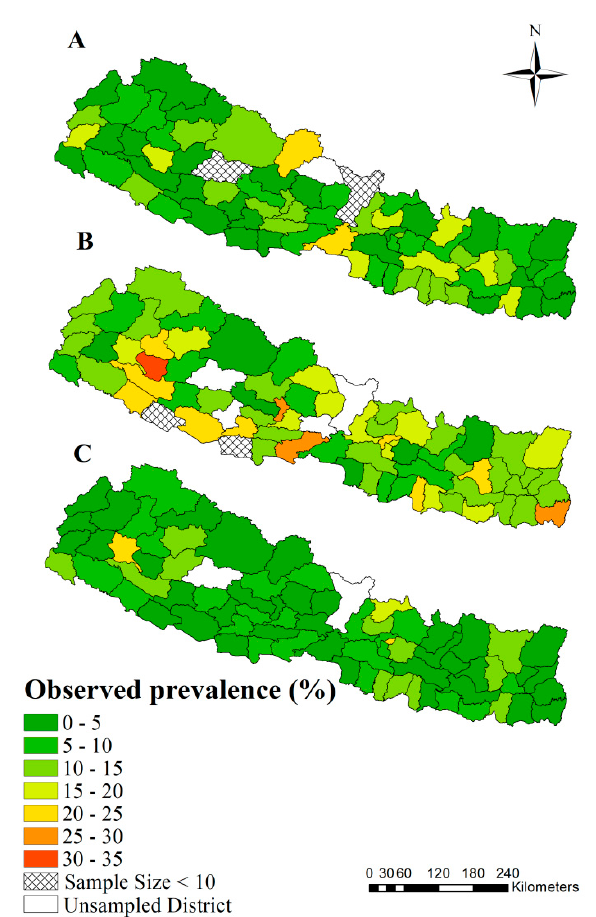
Figure 2. Observed prevalence of diarrhea at district-level among children under five years old in Nepal. (A), (B) and (C) indicate observed prevalence in the survey years 2006, 2011 and 2016, respectively.